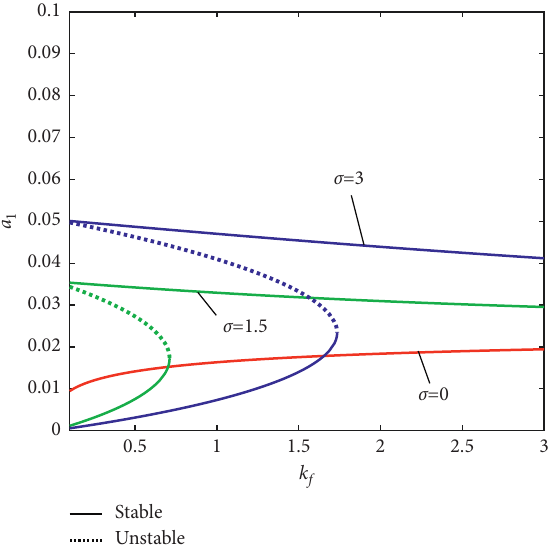
Figure 21: Amplitude versus cutting force coefficient with different detuning parameter values ( θ � 0 ° , c � 0.01, L/d � 10, case I).